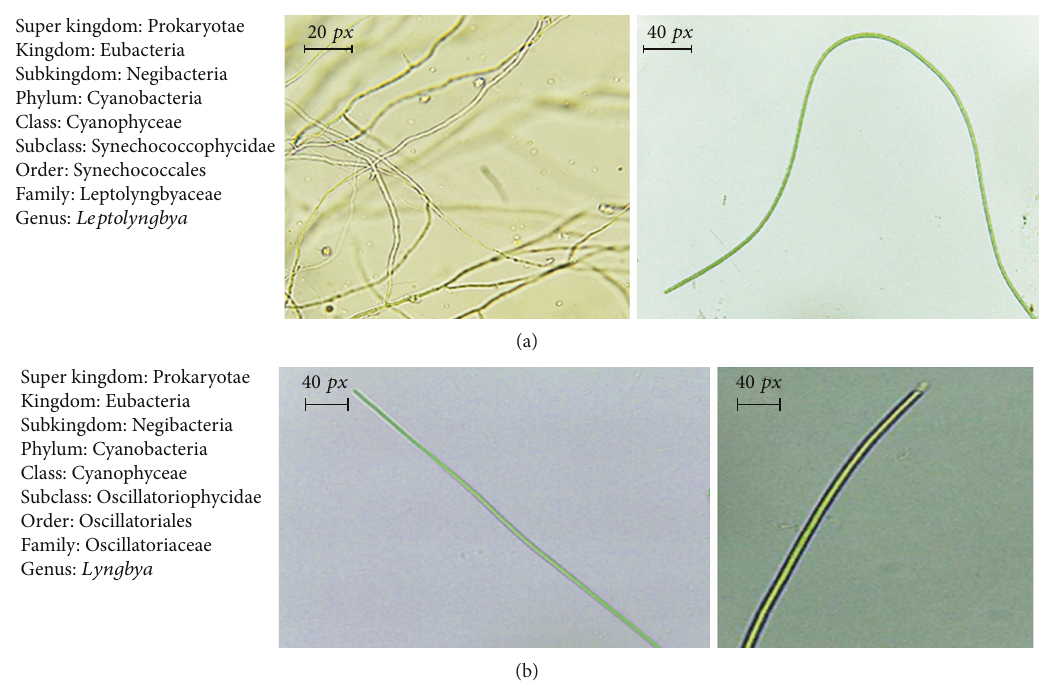
Figure 1: Taxonomic classi fi cation of cyanobacteria in the water samples: (a) Leptolyngbya and (b) Lyngbya [19 –